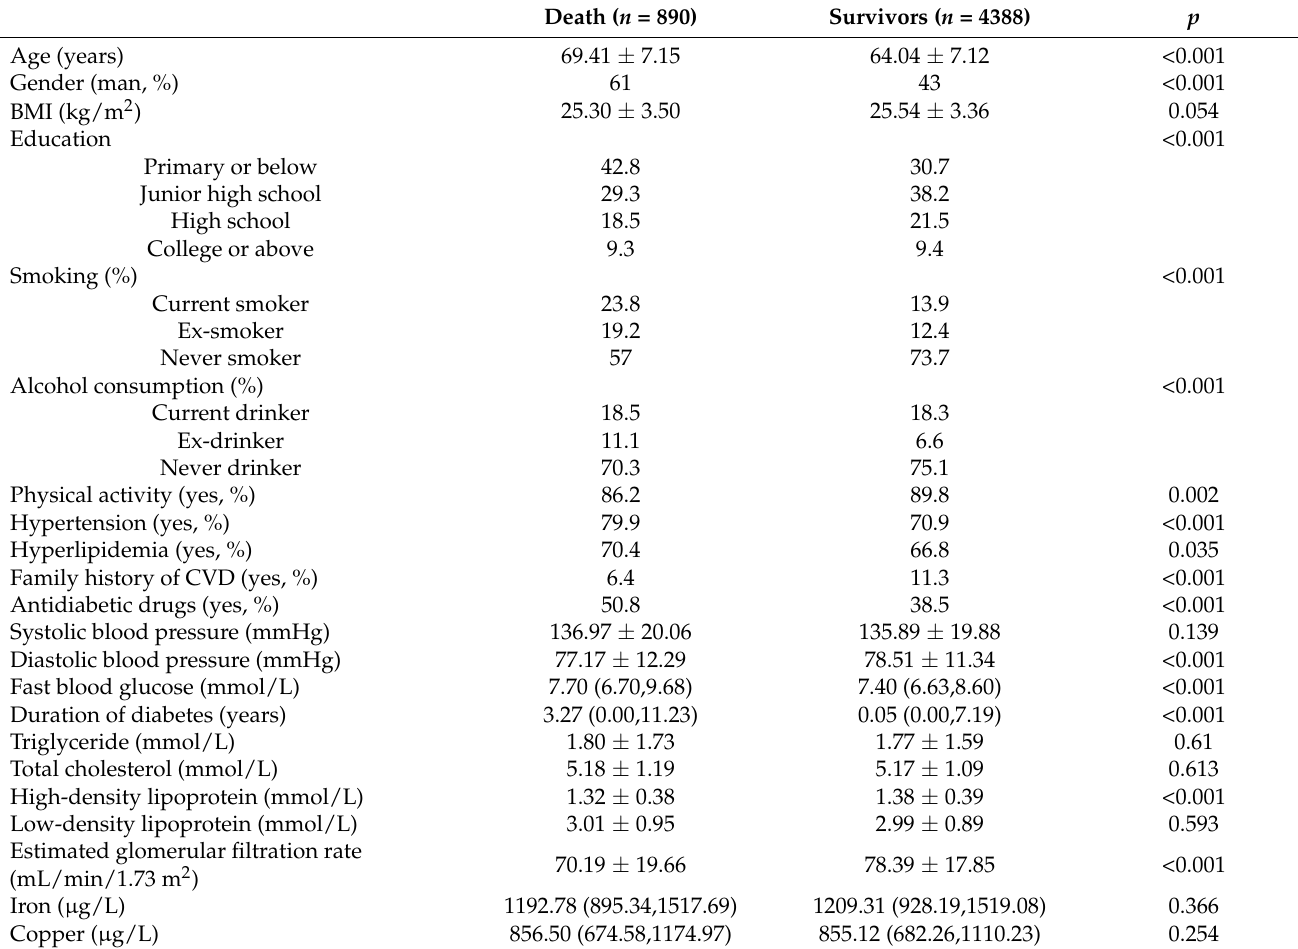
Table 1. Participants’ characteristics according to the vital status at the end of the follow-up ( n = 5278). Death ( n =